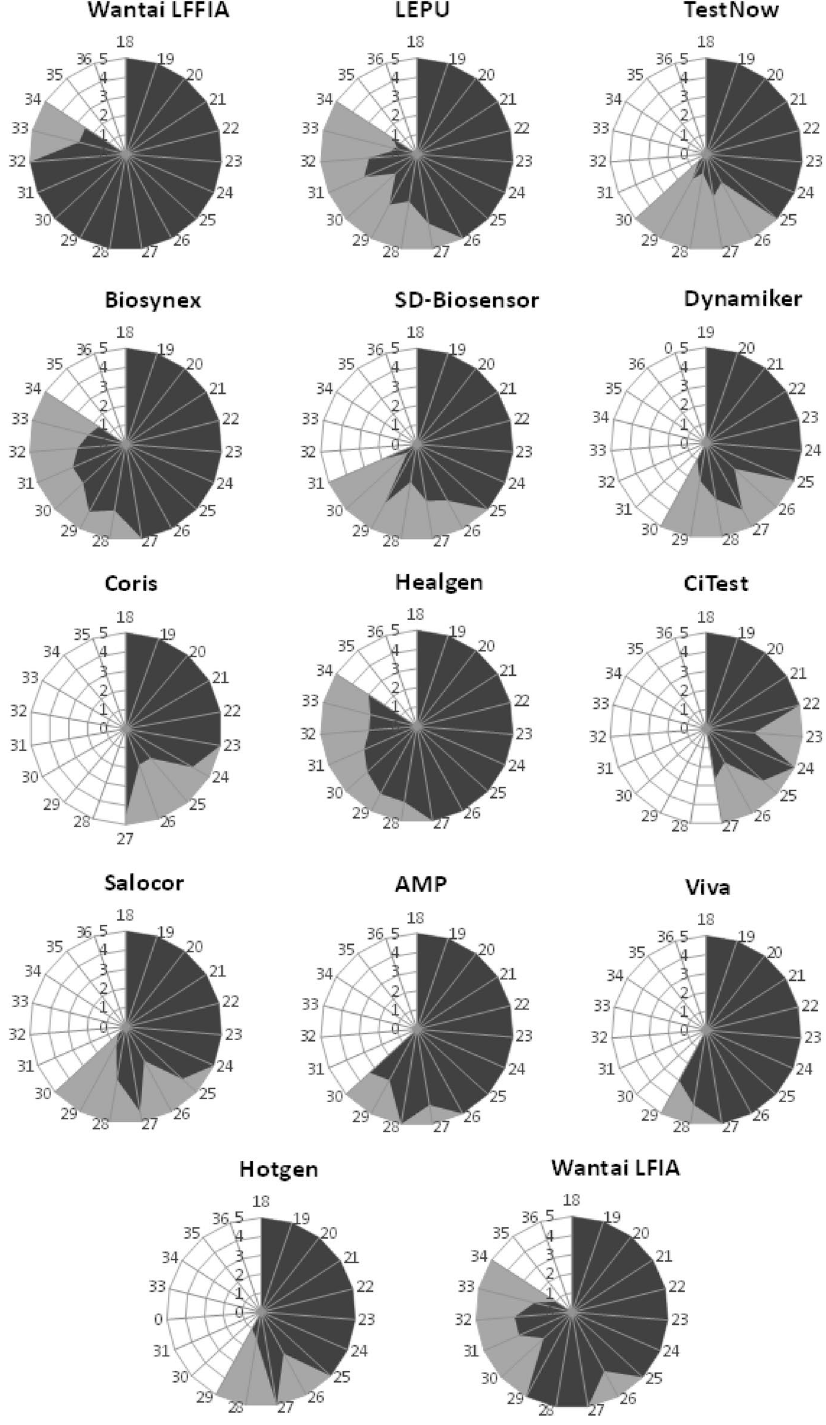
Figure 3. The diagnostic performance of each RAT is depicted as a spider graph. The length of each angular spoke (in dark grey) represents the average score (0–5) obtained by naked-eye visual inspection of the band for different samples of a designated cT. Different angles represent different cTs. The larger the area covered in blue, the strongest the test bands produced by this RAT. The second qualitative variable (in light gray) illustrates all the cTs of the samples that were successfully detected by this RAT and the area in gray defines the maximum sample’s cT that was found positive by this